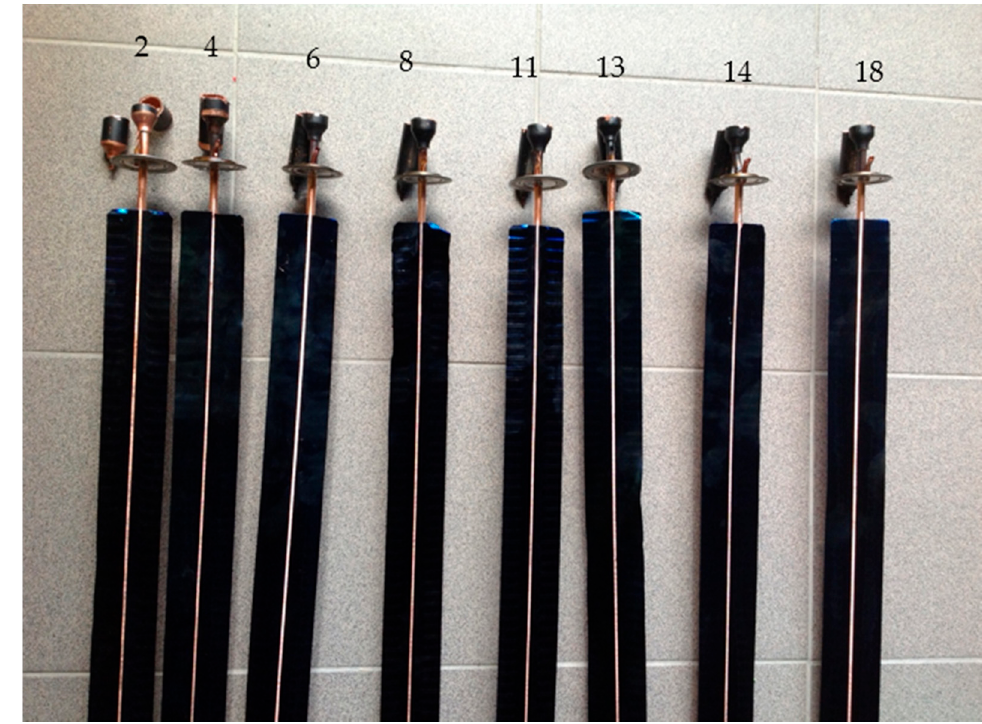
Figure 17. Tested heat pipes after incision. The working media of the heat pipes were decanted into measuring cylinders. The volume measurement was performed at 20 ° C . The measurement results are shown in Figure 18.